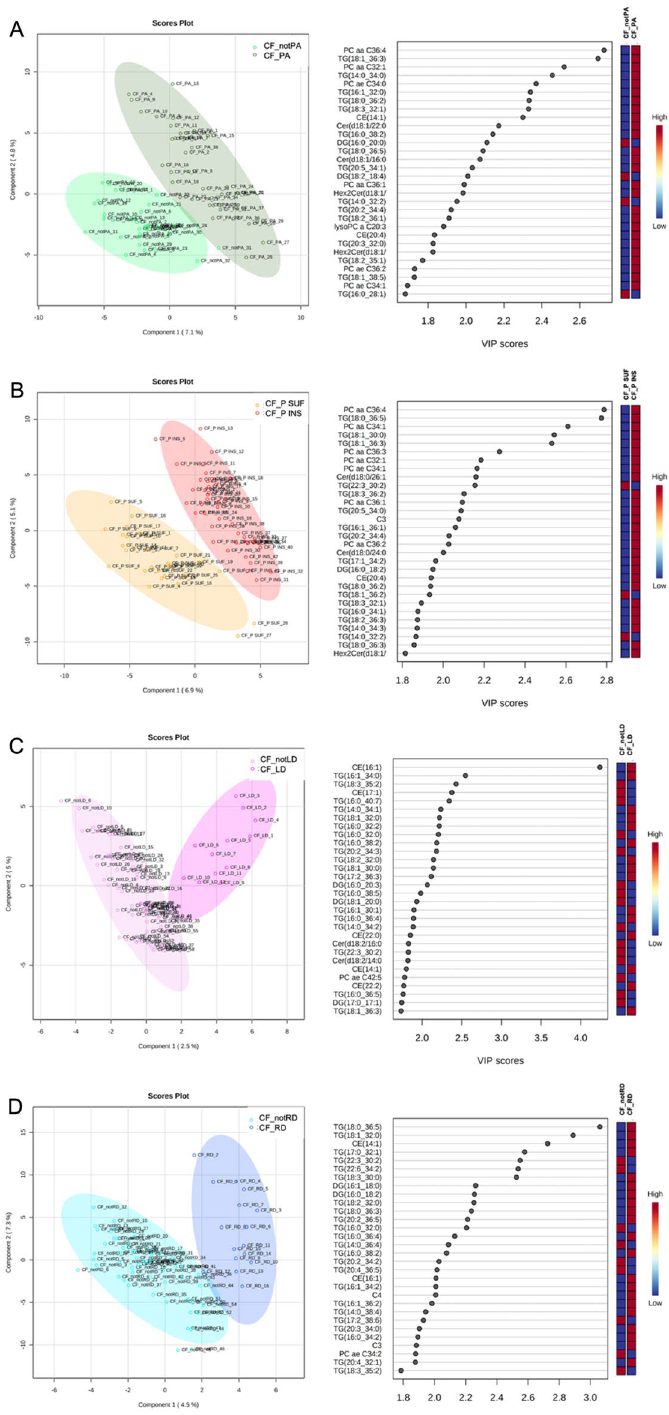
Figure 5. The supervised partial least squares-discriminant analysis (PLS-DA) plots, show the lipid segregation between patients with and without colonization by Pseudomonas Aeruginosa ( A ); patients with pancreatic sufficiency and insufficiency ( B ); patients with and without liver disfunction ( C ) and patients with or without diabetes related complication ( D ). The VIP score are assigned according to component 1. The 30 most important lipids, according to their VIP score are reported. The intensity of the colored boxes denotes the relative lipid abundance in each group of